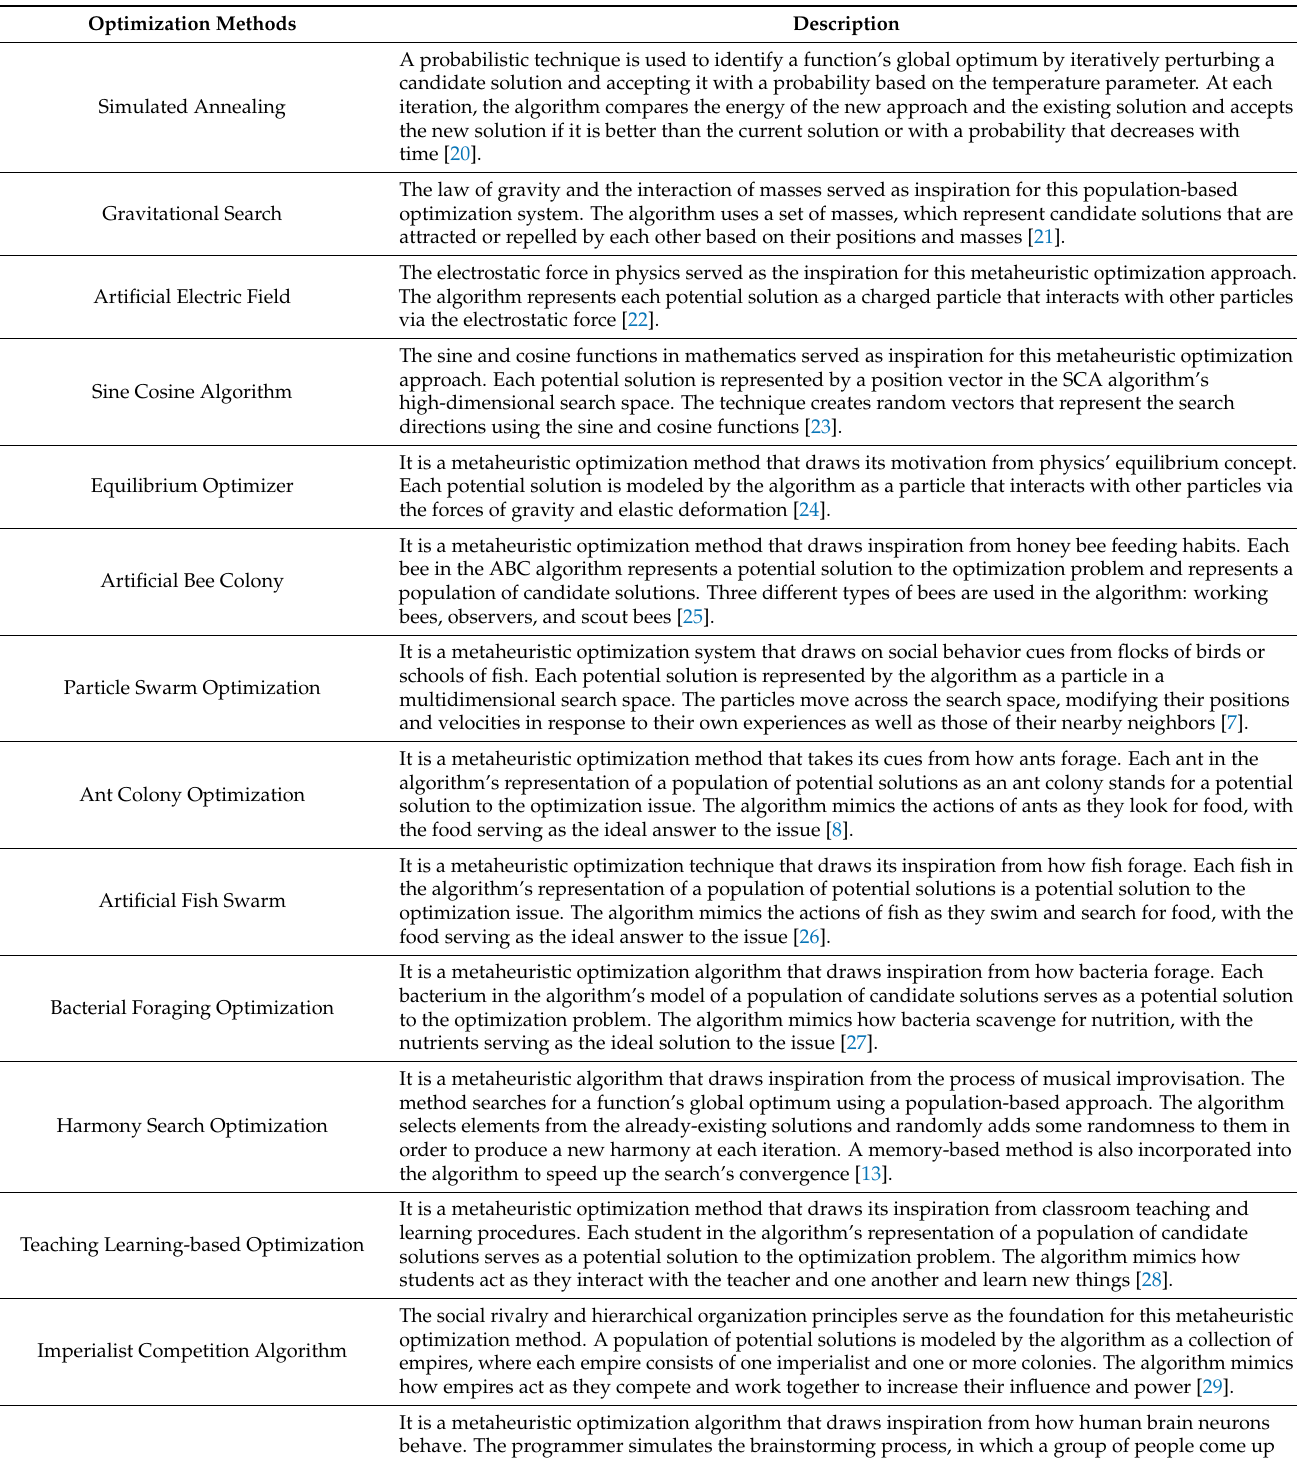
Table 1. Literature